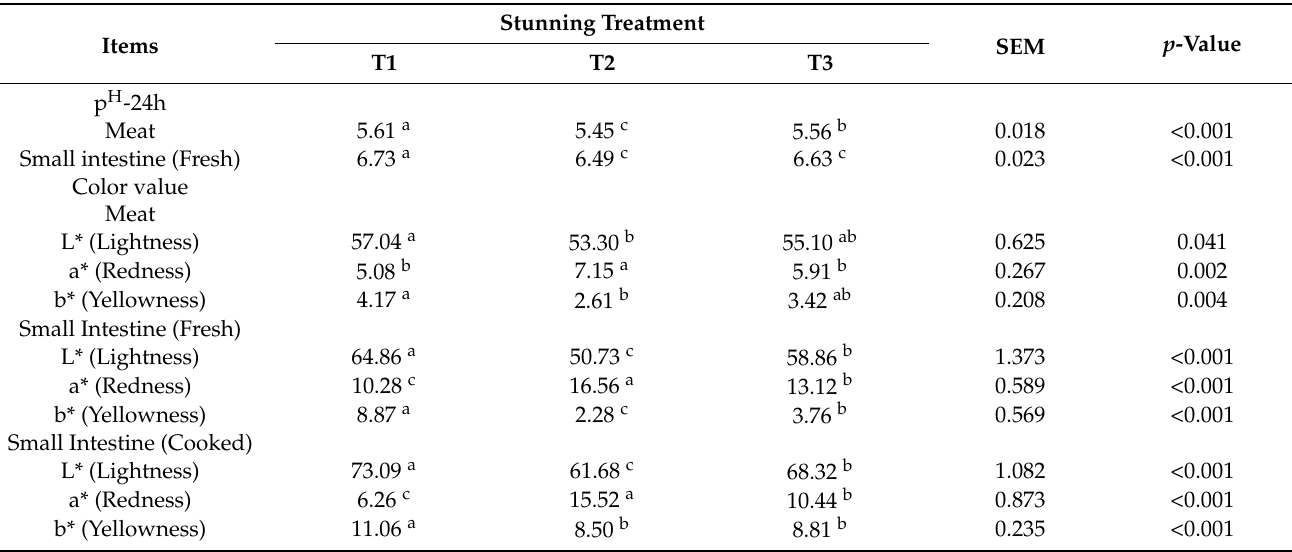
Table 1. Effect of electric and gas stunning (CO 2 -80% & N 2 -98%) on p H -24h and Color value of pigs meat and small intestine ( n = 7).